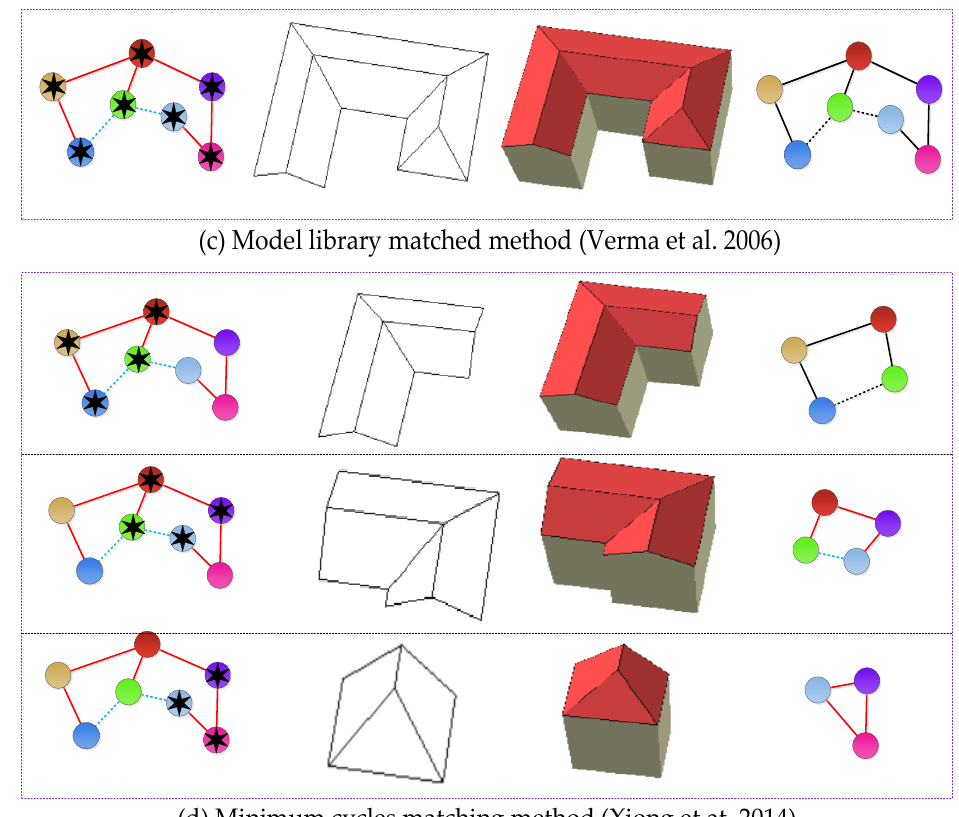
Figure 10. Decomposition results by different 3D building methods. ( a ) The original input point cloud and roof connection graph. ( b ) The results from the proposed approach. ( c ) A whole model by Verma et al. [51]. ( d ) Decomposition results by Xiong et al. [5]. The first to fourth columns of each row are grouped planes in the original roof connection graph, 3D wireframe, 3D model, and the final enriched subgraph of a grouped unit.